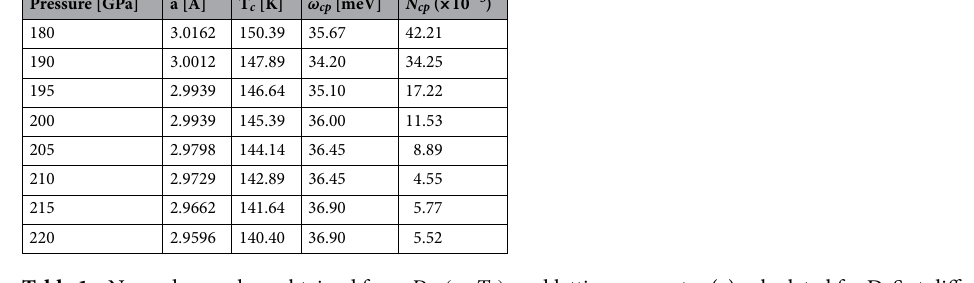
Table 1. N cp and ω cp values obtained from D cp (ω , T c ) , and lattice parameter (a) calculated for D 3 S at different pressures, contrasted with their respective experimental T c values 4